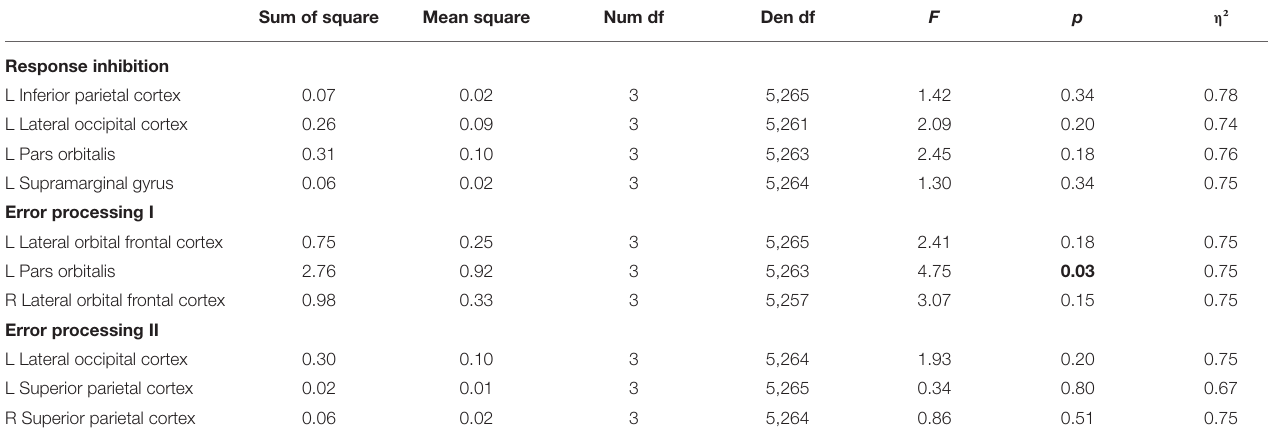
TABLE 3 | Group comparison of individual region of interest. Sum of square Mean square Num df Den df F p η ²